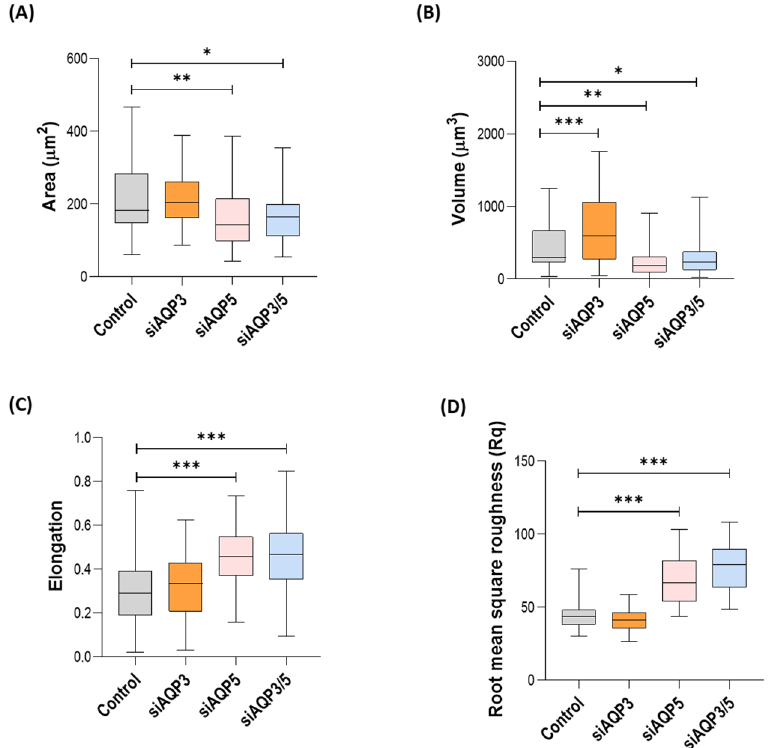
Figure 5. Morphological characteristics of the BxPC-3 cells under evaluation. ( A ) Cell area, ( B ) volume, ( C ) elongation (length of the shorter axis over the length of the longer axis), and ( D ) surface roughness. Results were obtained in three independent experiments, with at least 30 cells analyzed in each of them. * p < 0.05; ** p < 0.01; *** p <0.001; silenced vs. control cells.